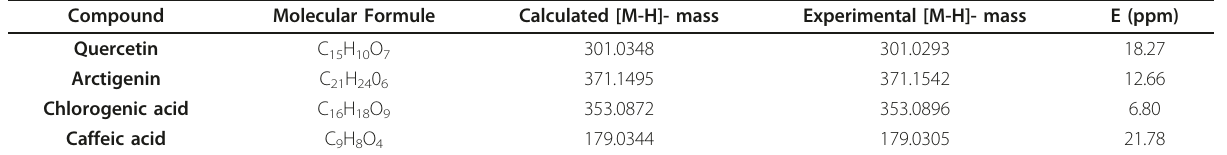
Table 3 High-resolution eletrospray ionization mass spectrometry (HRESI-MS) data of Quercetin, Arctigenin, Chlorogenic acid, and Caffeic acid identified in the hydroethanolic extract of Arctium lappa root Compound